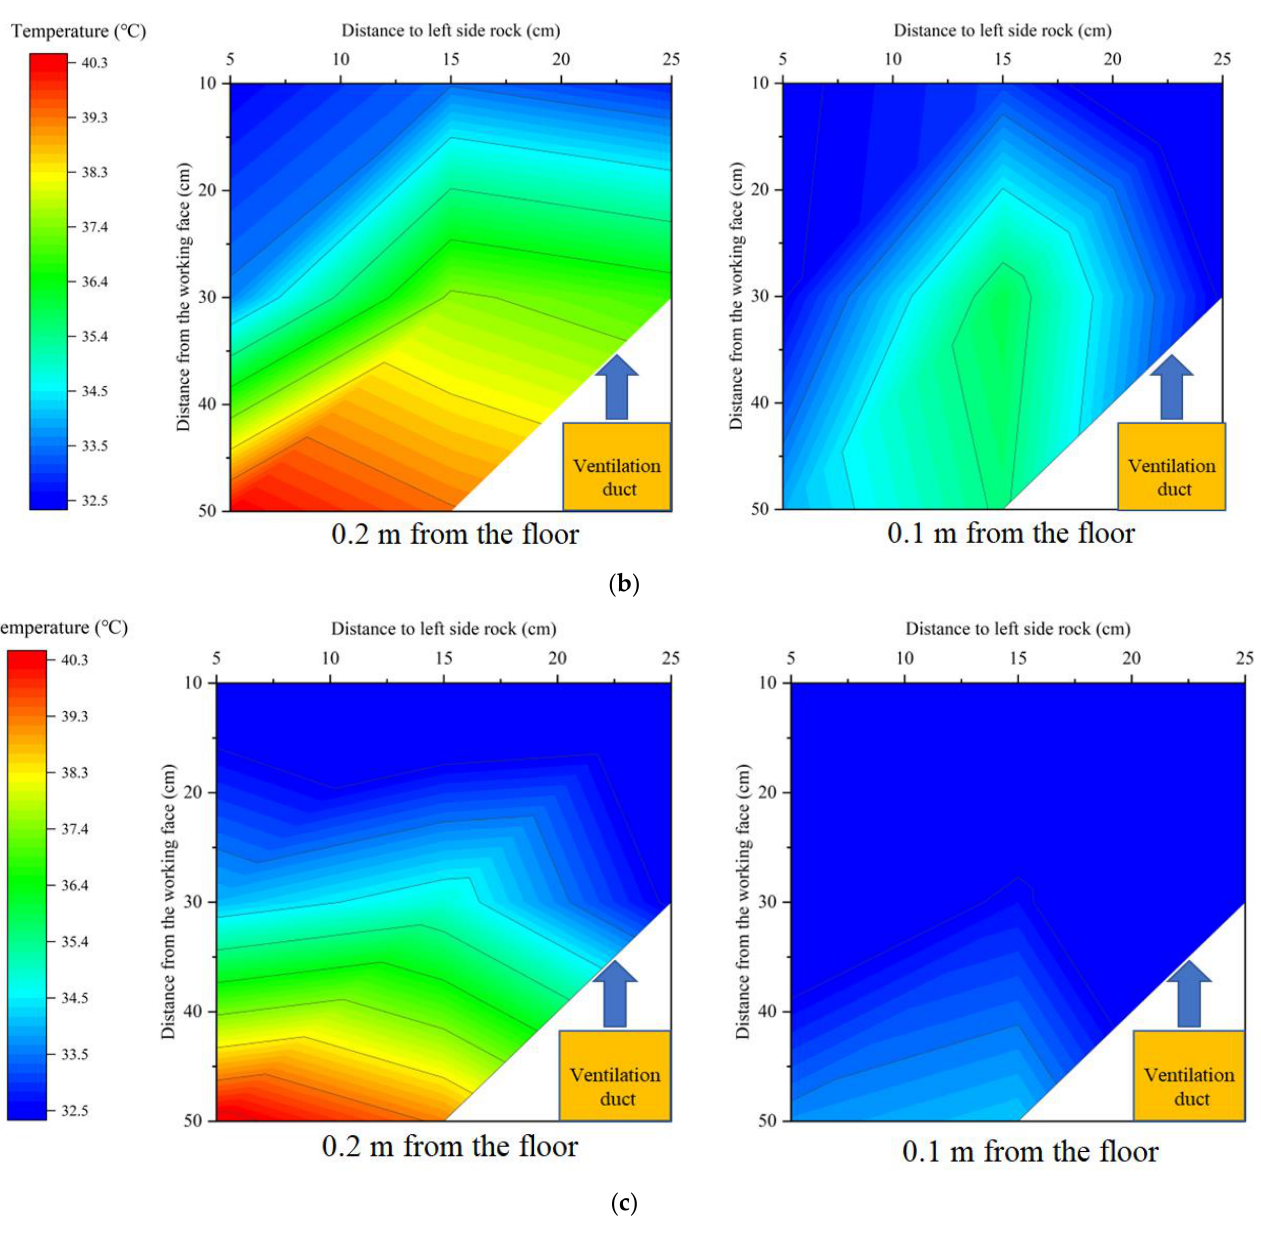
Figure 12. Working area temperature field under different heat exchange layer arrangement cases: ( a ) Without heat exchange layer; ( b ) Single heat exchange layer; ( c ) Double heat exchange layer.